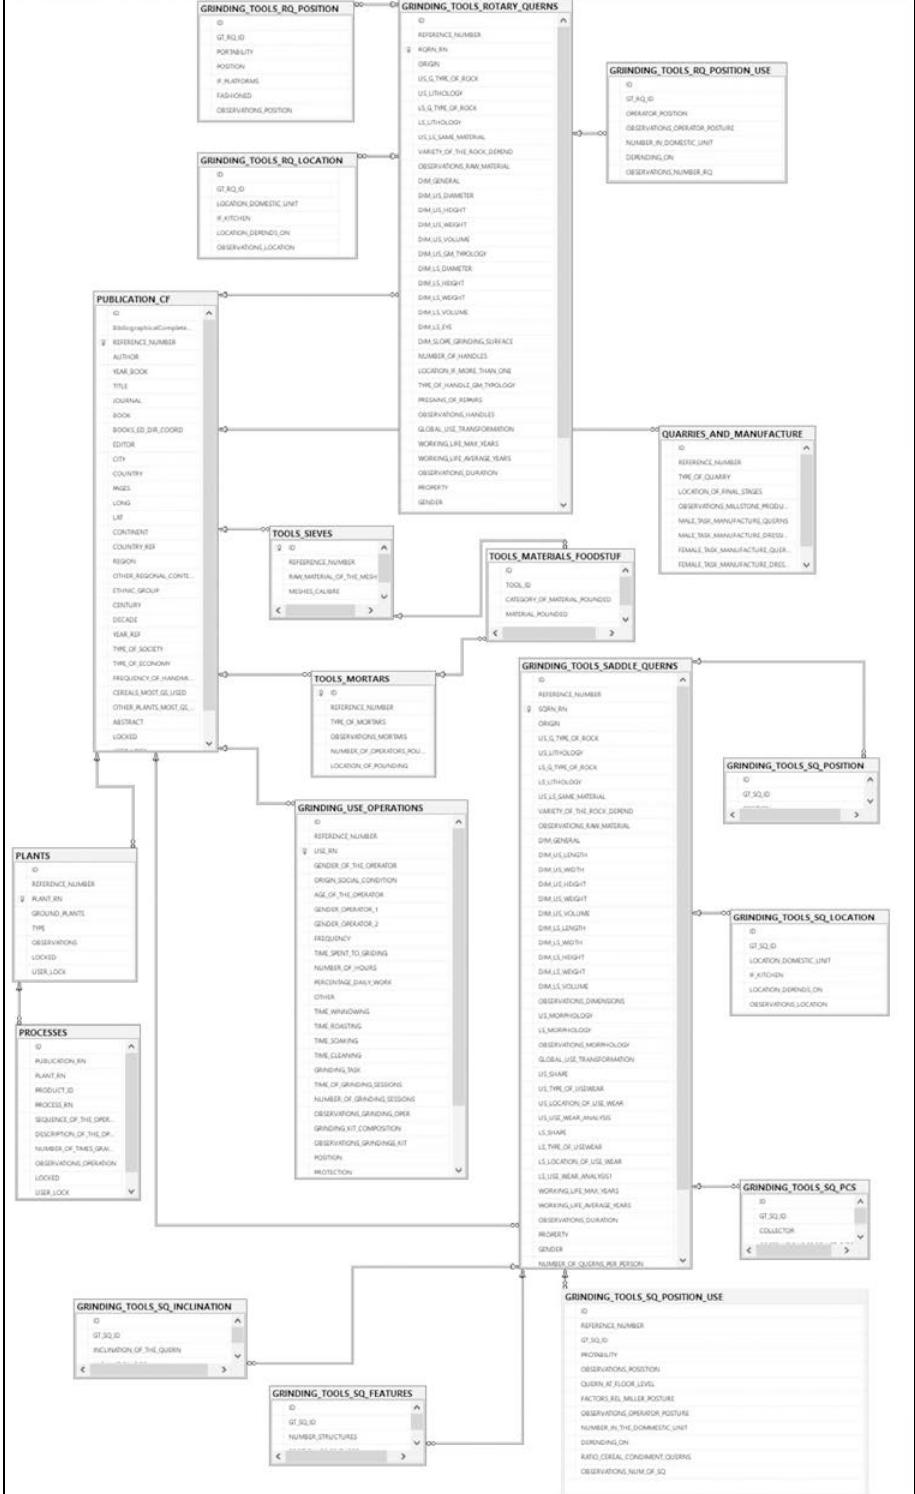
Figure 2. Schema of the computer structure of the Ethnogrinding